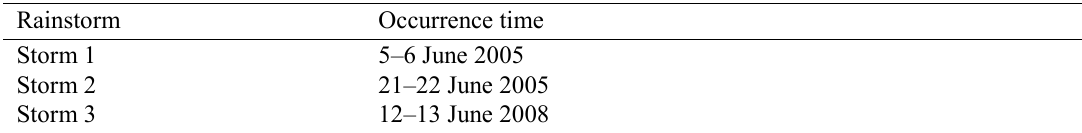
Table 1 Occurrence time of selected rainstorms over Xijiang basin Rainstorm